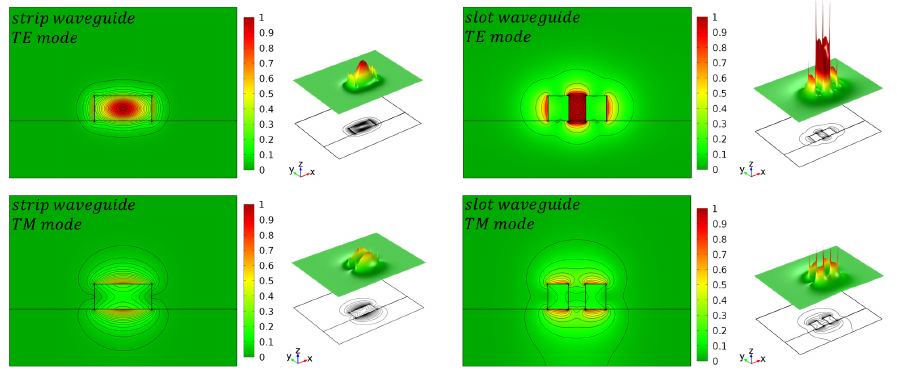
Figure 3. Simulation of the normalized E-field intensity for the first TE- and TM-mode for a strip and slot waveguide. Reproduced from Ref. [38] (CC BY